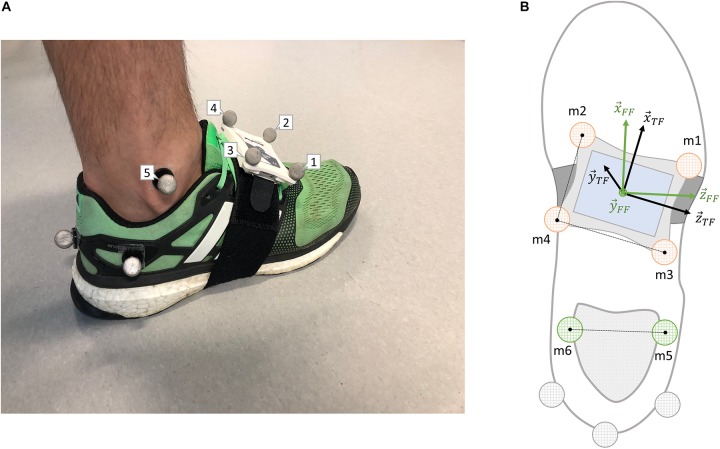
(A) Rear/lateral view of the markers’ configuration used in this study. (B) Top scheme of the markers’ configuration required in the definition of the foot’s technical (TF) and functional (FF) frames. Markers illustrated in orange are the one needed to set the TF, in green the FF, and in gray the duplicates which were not used in this study. Also, note that markers 5 and 6 were kept only during the calibration trials.